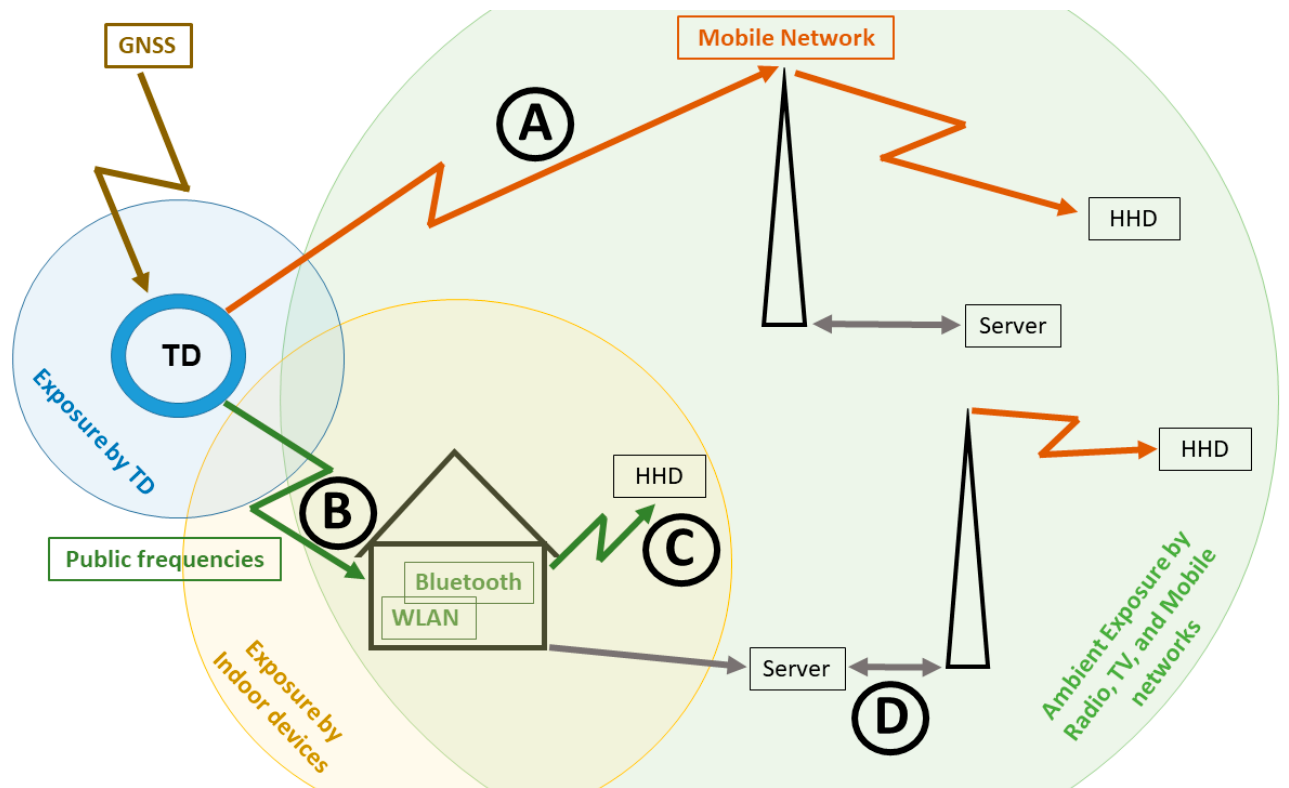
Figure 1. Schematic diagram showing the pathways of the global navigation satellite system (GNSS) signal used by the tracking device (TD) and the transfer of the positioning data via a mobile network to a handheld device (HHD) (pathway A) or via licence-exempt frequencies (WLAN, Bluetooth) to a base station at home (pathway B). The data are then transferred in the near field by WLAN or Bluetooth (pathway C) to an HDD or via the Internet to a mobile phone (pathway D). The degree of exposure of pets to RF-EMF by TDs, indoor devices, and radios, televisions, and the base stations of mobile networks (ambient exposure) is shown by coloured circles.